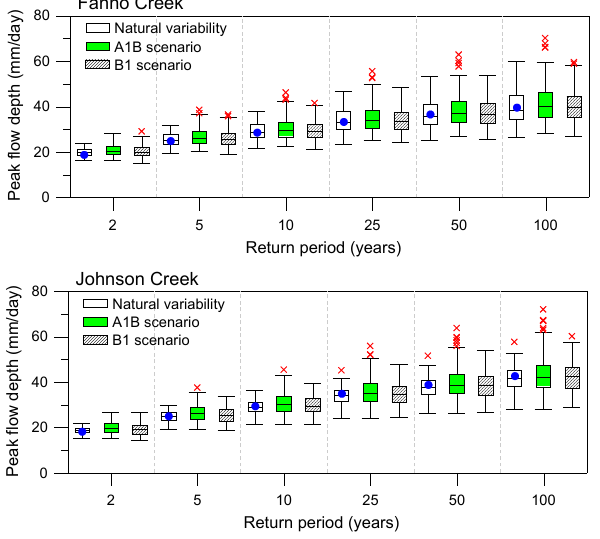
3 Fig. 6. Variation of flood frequency by climate change scenarios, Fig. 6. Variation of flood frequency by climate change scenarios, with recurrence 4 with recurrence intervals of 2, 5, 10, 25, 50, and 100 years for the intervals of 2, 5, 10, 25, 50, and 100 years for the 2050s with respect to the reference 5 2050s with respect to the reference period of 1960–1989. The blue period of 1960-1989. The blue dot indicates flood frequency using observed climate 6 dot indicates flood frequency using observed climate data and sym- data and symbol (x) indicates outliers. 7 bol (x) indicates outliers. 8